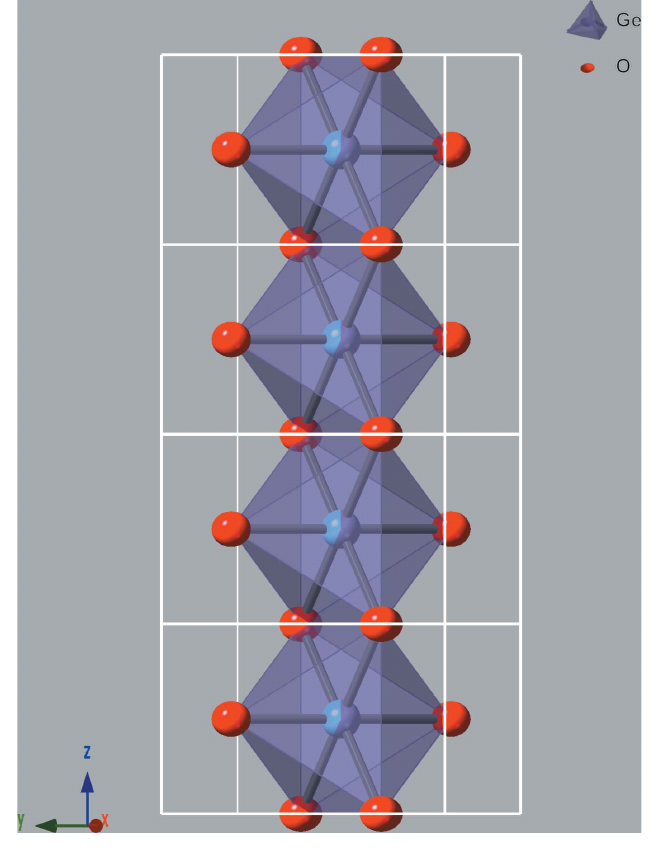
Figure 2 View of the edge-sharing chain of M O 6 octahedra in Ge 0.57 Ti 0.43 O 2 . The symbols are the same as in Fig. 1.